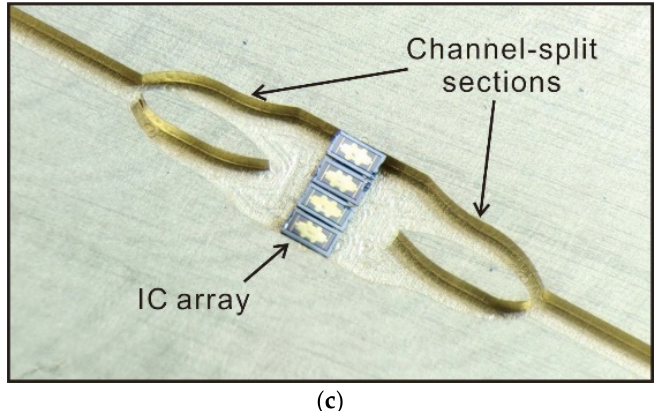
Figure 1. WR-3.4 waveguide module containing four-element IC array. ( a ) Photograph of the fully assembled waveguide module; ( b ) E-plane sketch of the middle expanded-channel section; ( c ) photograph of the split module showing the expanded-channel section.